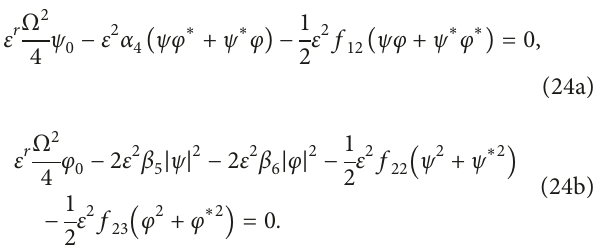
Figure 4: Possible relationship of internal resonances: (a) frequencies obtained under different values of A different values of i 0